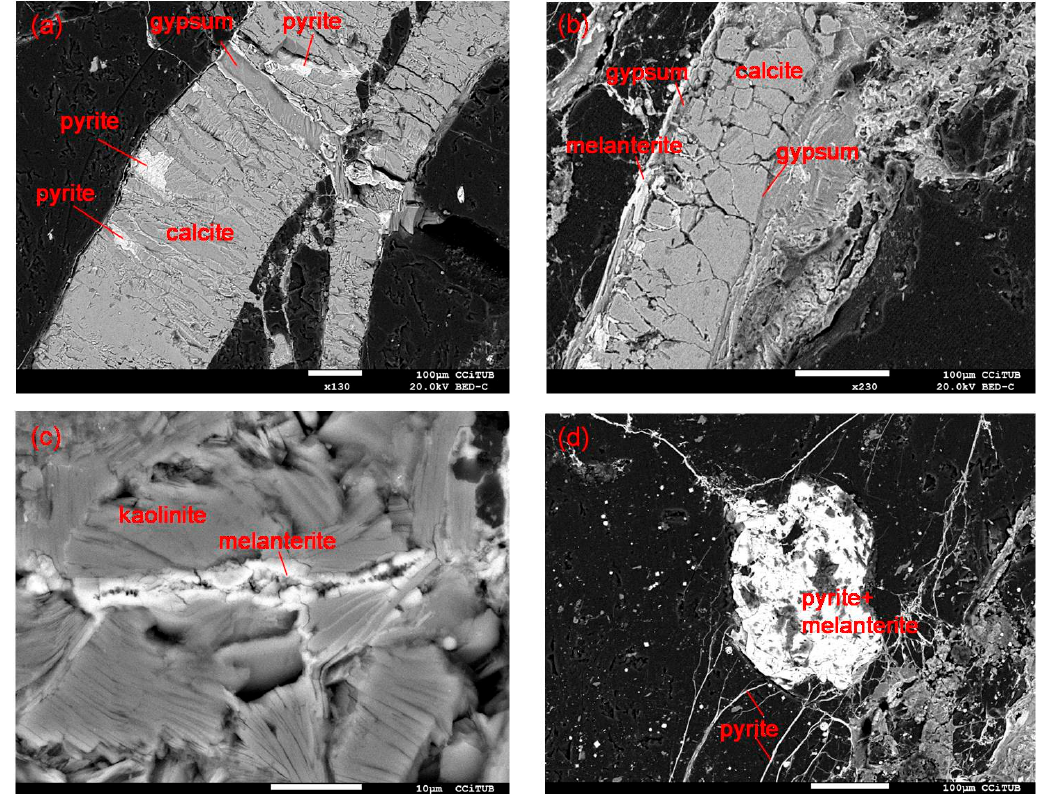
Figure 11. SEM back-scattered images of several cleat- / fracture-infilling minerals in No. 11 coal from the Sangshuping mine. ( a ) fracture-infilling calcite, gypsum and cleat-infilling pyrite; ( b ) fracture / cleat-infilling calcite, gypsum and melanterite; ( c ) authegenic kaolinite and cleat-infilling melanterite ( d ) fracture / cleat-infilling pyrite and intergrown melanterite.